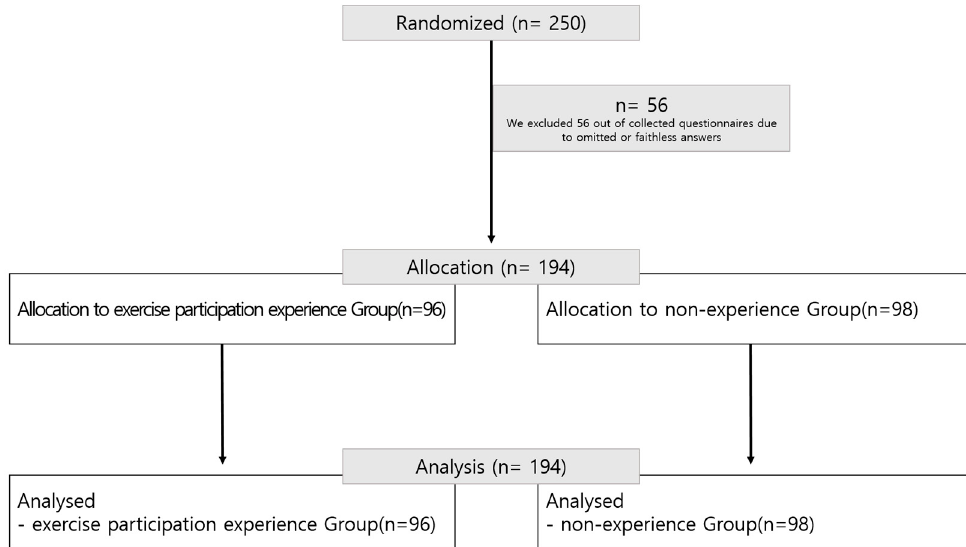
Figure 1. Participant allocation (consolidated standards for reporting the trial as a flow diagram).